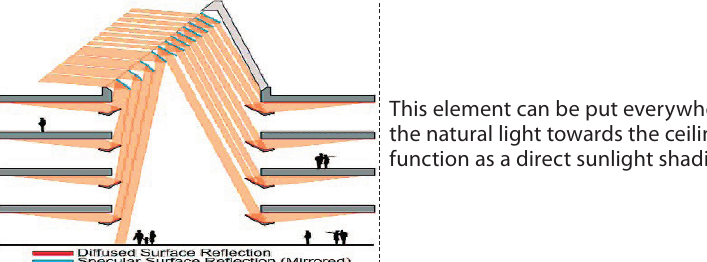
Fig. 7. Various forms of internal light shelf